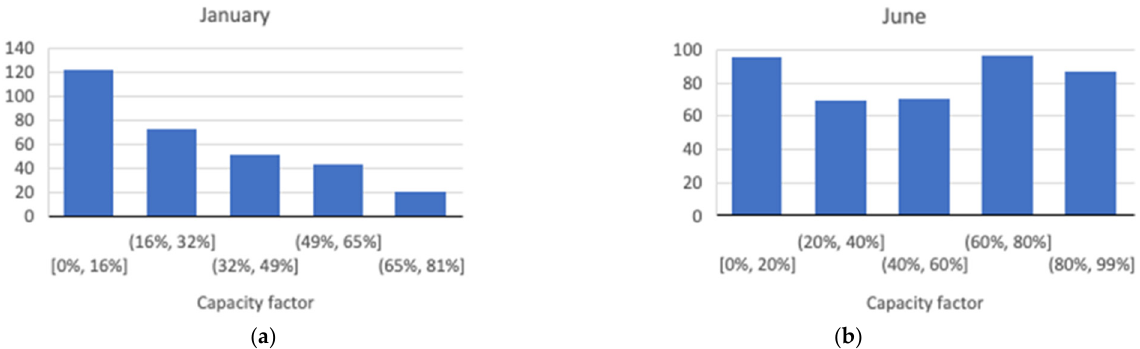
Figure 14. Capacity factor repetitions for the PV system in a hybrid system.